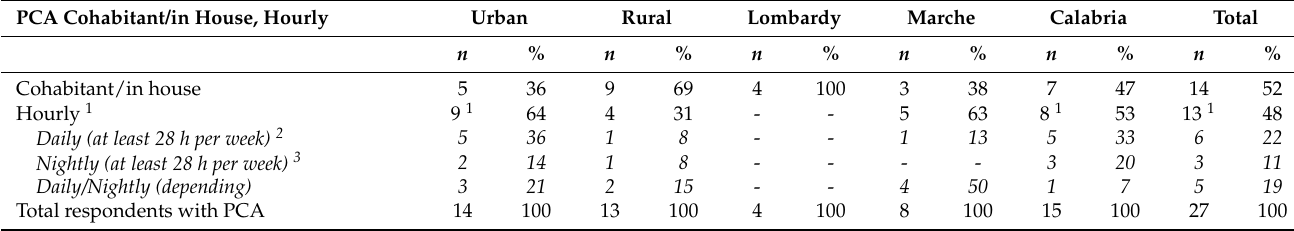
Table 5. PCA presence: cohabitant-in house/hourly, by sites and